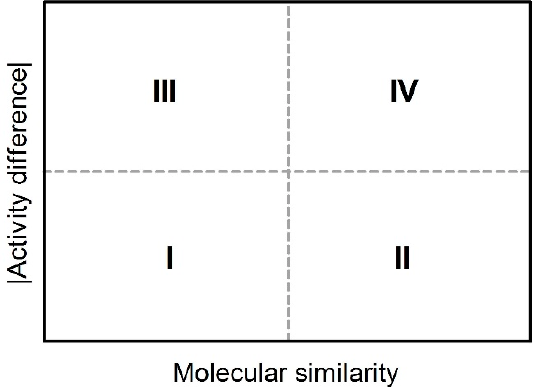
Figure 4. General form of the structure–activity similarity (SAS) maps showing four major regions.